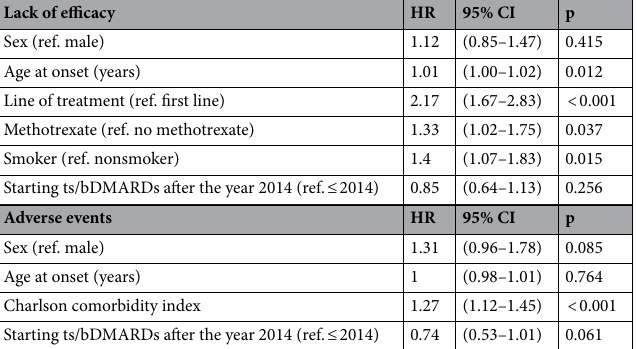
Lack of efficacy HR 95% CI p Sex (ref. male)